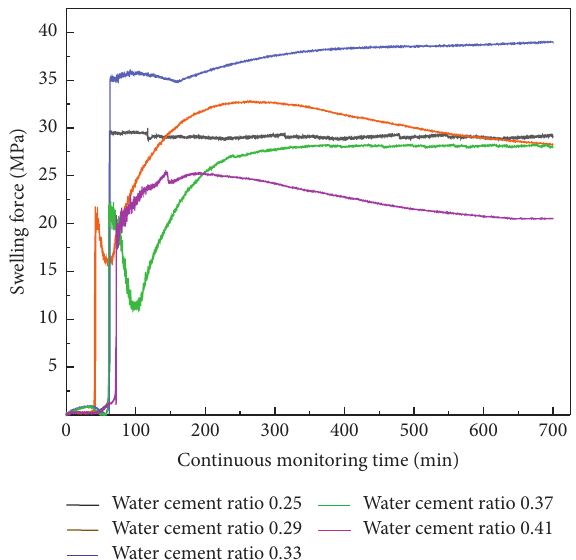
Figure 7: Swelling force change characteristics at various water-cement ratios.